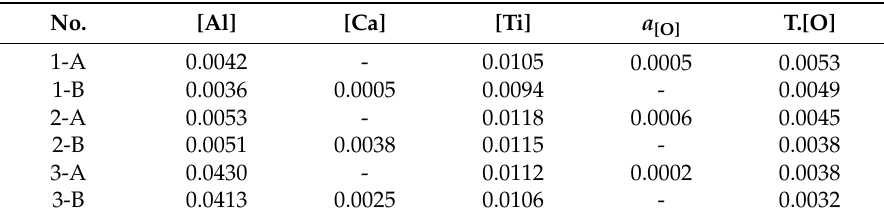
Table 2. The compositions of the obtained sample (mass